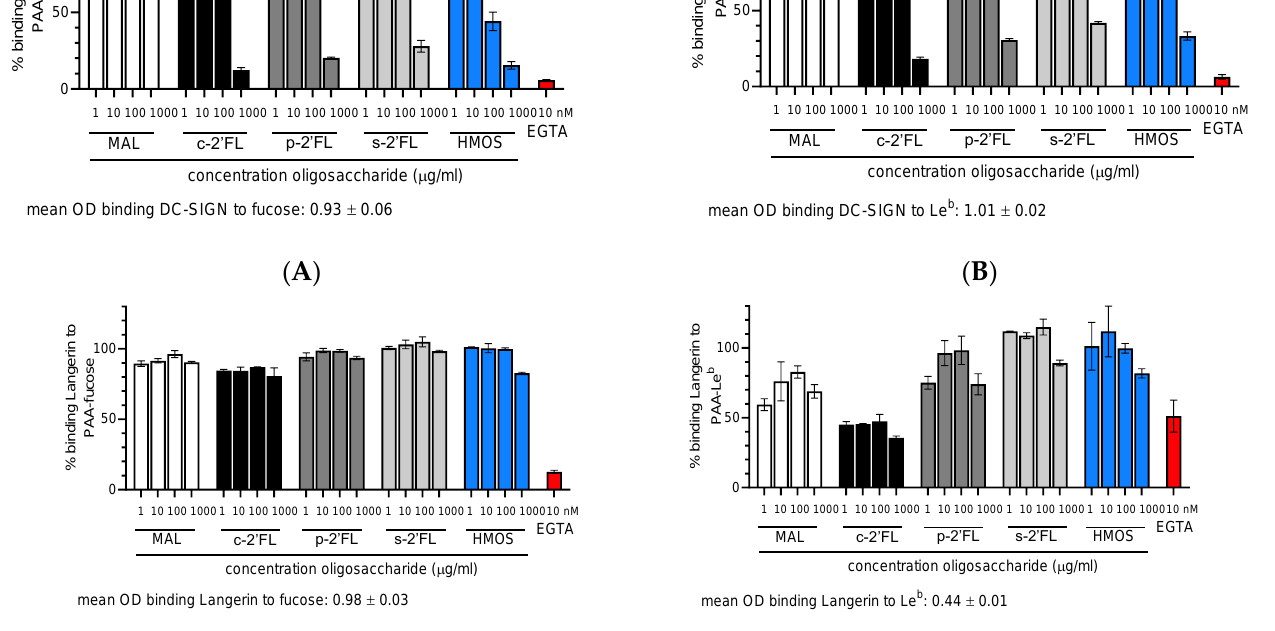
Figure 2. Ligand-receptor competition assay for the DC-SIGN-Fc and langerin-Fc (5 µg/mL) binding to PAA-fucose or PAA-Le b with maltotriose (MAL, negative control), c2 ꞌ -FL, p2 ꞌ -FL, s2 ꞌ -FL and HMOS [in various concentrations of 1 µg/mL, 10 µg/mL, 100 µg/mL, and 1000 µg/mL ]. EGTA [10 nM] was used to demonstrate the Ca +2 -and Mg +2 dependent binding of DC-SIGN and langerin to the PAA-fucose and PAA-Le b ligands. ( A ) inhibition by 2 ꞌ -FLs and HMOS of the binding of DC-SIGN-Fc (5 µg/mL) to the ligand PAA-fucose; ( B ) inhibition by 2 ꞌ -FLs and HMOS of the binding of DC-SIGN-Fc (5 µg/mL) to the ligand PAA-Le b ; ( C ) No effect of 2 ꞌ -FLs and HMOS on the binding of langerin-Fc (5 µg/mL) to the ligand PAA-fucose; ( D ) No effect of 2 ꞌ -FLs and HMOS on the binding of langerin-Fc (5 µg/mL) to the ligand PAA-Le b . Results are presented as the mean % binding of the ligand to DC-SIGN-Fc and langerin-Fc ± SD, data from two separate experiments, performed in duplicate (n = 4 technical replicates). No block condition is regarded as 100% ligand-DC-SIGN-Fc/langerin-Fc binding. c-2 ꞌ -FL = biotechnologically produced commercially available 2 ꞌ -FL, p2 ꞌ -FL = purified c-2 ꞌ -FL and s2 ꞌ -FL = chemically synthesized 2 ꞌ -FL.